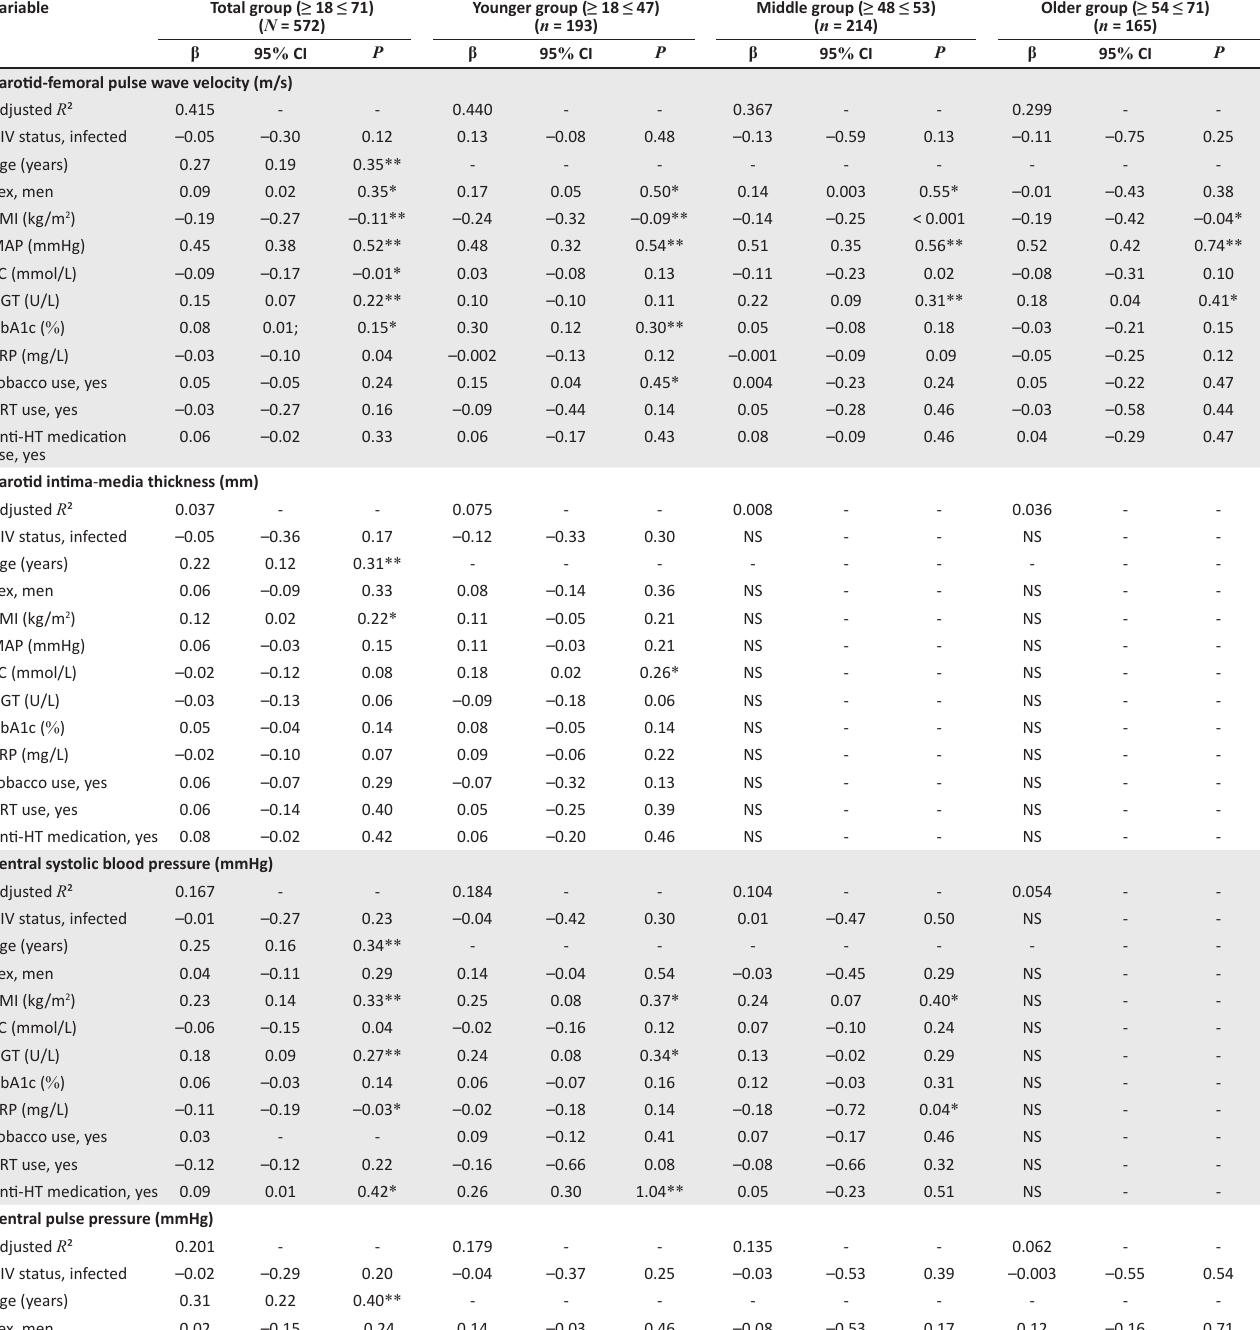
TABLE 2-A1: Multiple regression analyses between vascular measures and HIV status in the total group and in different age tertile groups. Variable